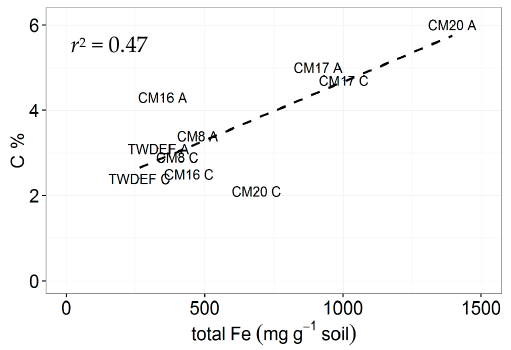
Figure 5. Relationship between total extractable Fe (mg · g − 1 soil) and C concentrations in 0–10 cm depth soils from CM and TWDEF. The labels in the graph correspond to the plot labels in Table 1. “A” indicates aspen plots, and “C” indicates conifer